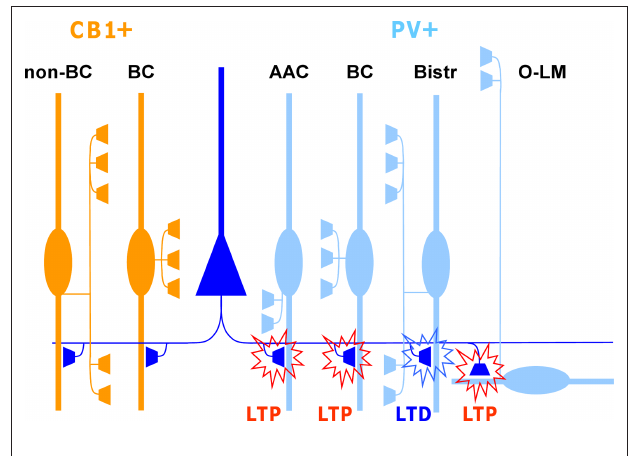
FiGure 1 | Glutamatergic fiber plasticity on hippocampal CA1 interneurons is specific to a GABAergic cell type. Schematic illustrates cell type-specific plasticity in six anatomically identified interneuron types. Repetitive high-frequency (100 Hz tetanic or theta burst) stimulation of pyramidal cell axons induces target cell-specific plasticity in parvalbumin- expressing (PV + ) interneuron types, whereas interneurons expressing cannabinoid receptor type 1 (CB1R + ) but not PV, show no plasticity with these protocols. PV and CB1R are mutually exclusive neurochemical markers and cell types belonging to these two groups form very similar inhibitory circuits in the CA1. Detailed anatomical analyses reveal that glutamatergic synapses onto PV + axo-axonic (AAC), basket cells (BC) and oriens-lacunosum moleculare (O-LM) interneurons show consistently LTP, whereas bistratified cells (Bistr) show predominantly LTD. In contrast, synapses onto BCs expressing CB1R or dendrite-targeting CB1R + non-basket cells (non-BC) show no long-term plasticity at all (Lamsa et al., 2007b; Oren et al., 2009; Nissen et al.,